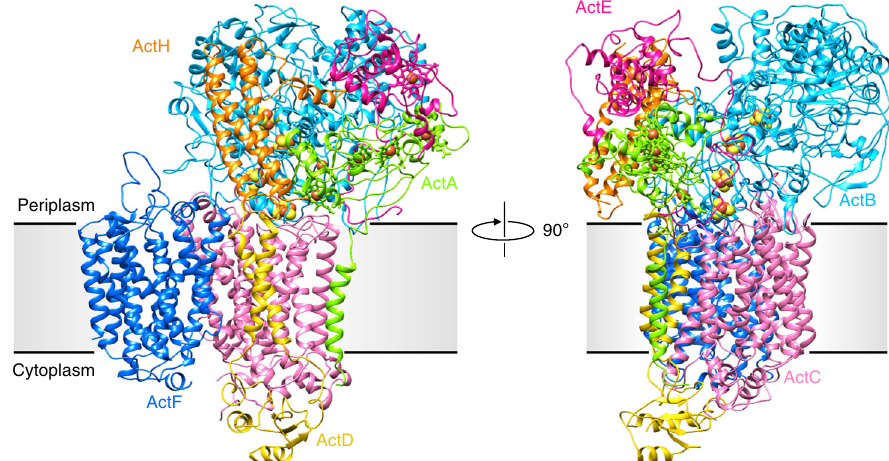
Fig. 1 Overall structure of ACIII. ACIII is composed of at least seven subunits; the peripheral subunits ActA (green), ActB (cyan), ActE (magenta), and ActH (orange), and the membrane subunits ActC (pink), ActD (yellow), and ActF (blue). ActB coordinates four iron – sulfur clusters (orange/yellow spheres). ActA binds fi ve hemes (green sticks and orange spheres) and ActE one heme (magenta sticks and orange sphere). The gray band indicates the